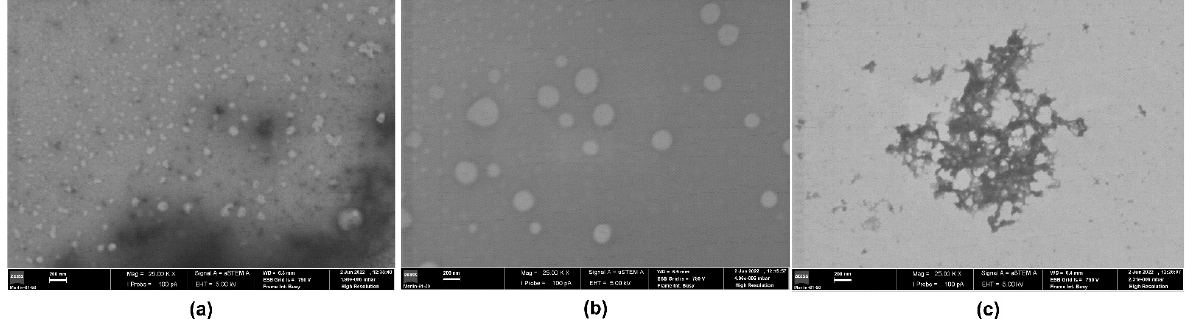
Figure 3. STEM images of: ( a ) CUR-[BMPYRR][NTf 2 ]@ncSi; ( b ) CUR-[OMIM][NTf 2 ]@ncSi; and ( c ) CUR-[P 6,6,6,14 ][NTf 2 ]@ncSi. Scale bar: 200 nm.